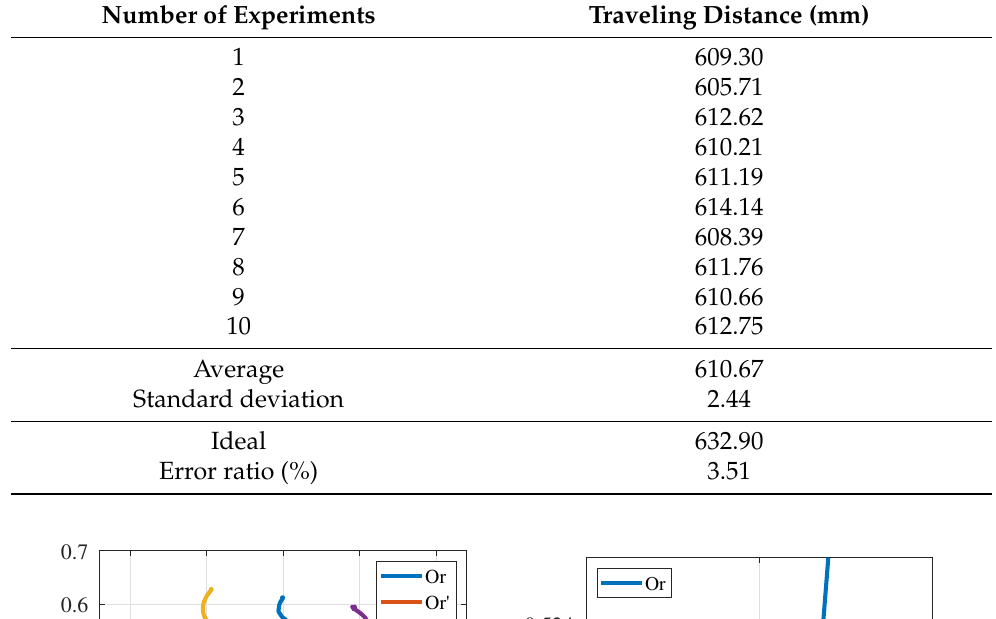
Table 5. The results of the forward locomotion experiments.